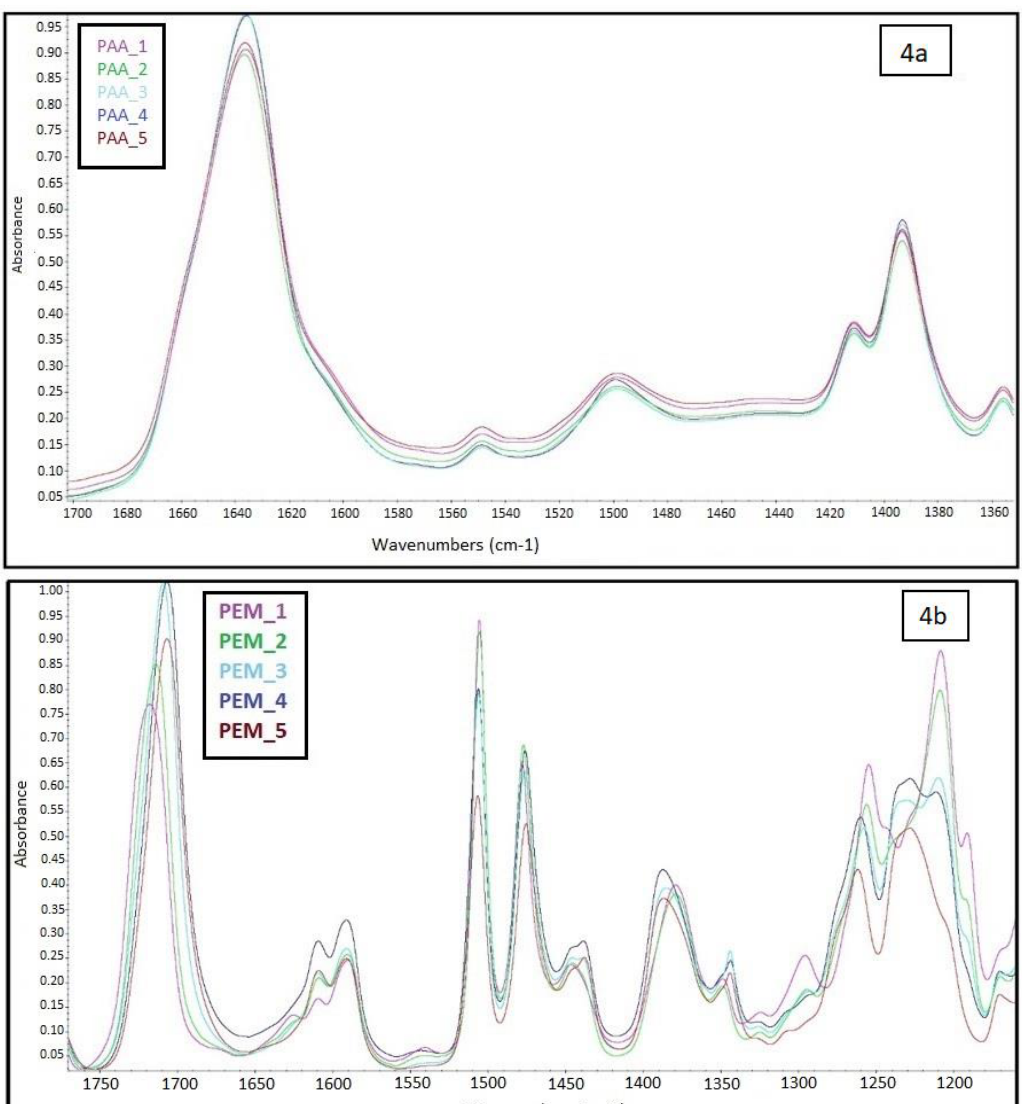
Figure 4. Zoomed FTIR spectra of PAA_1–PAA_5 solutions ( a ) and PEM_1–PEM_5 membranes ( b ) between 1750 and 1200 cm −1.